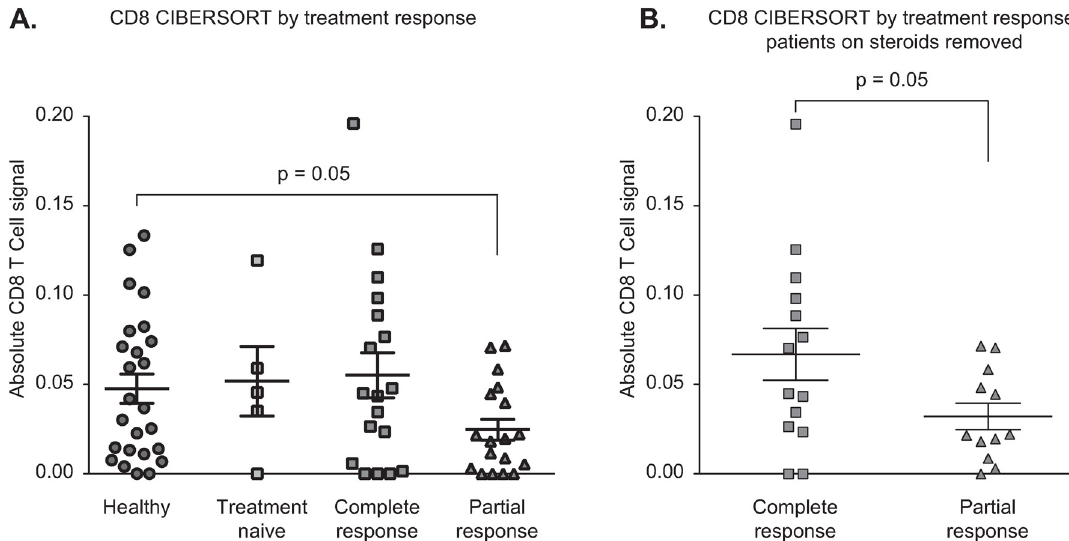
Fig 4. A. CIBERSORT data deconvoluting absolute CD8+ T-cell counts from bulk RNA-seq, with significant differences in counts between healthy patients and those with a partial response to treatment and between those with a complete compared to a partial response to treatment. B. CIBERSORT data deconvoluting absolute CD8+ T-cell counts from bulk RNA-seq, removing steroid patients and showing a significant difference between those with a complete compared to a partial response to treatment. hub genes (Fig 3 and S3 Table). Plotting these 12 genes in a heatmap using hierarchical cluster-